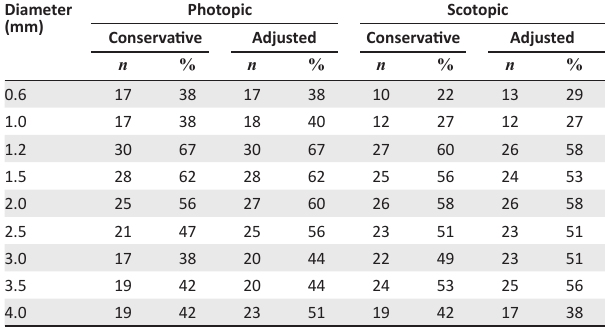
TABLE 1: The number ( n ) and percentage of subjects where visual acuity improved through the various pinhole diameters. Diameter Photopic Scotopic (mm)